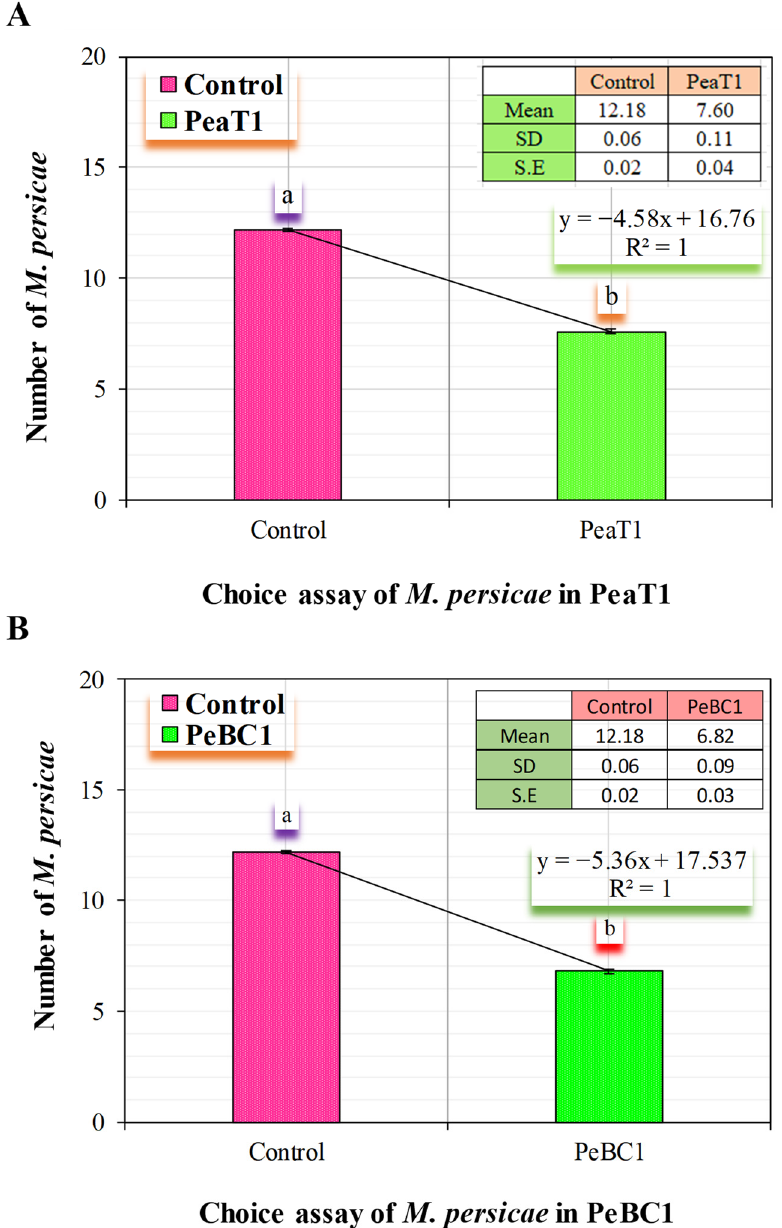
Figure 1. M. persicae feeding preferences ( A ) M. persicae preferred feeding on control plants in PeaT1; ( B ) M. persicae feeding on PeBC1-treated and control-treated chilli seedlings 24 h after infestation colonization (mean ± SD). SPSS 18.0 was used to compare data using one-way analysis of variance (ANOVA) and the least significant difference (LSD). Lower style alphabet letters show significant variations across all treatments. ( p = 0.05 ).